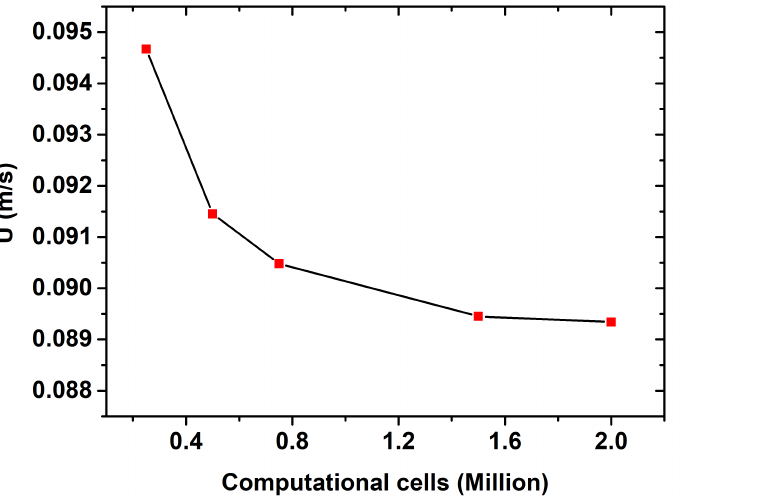
Figure 5. Velocity in the outlet 1 of the carotid model under different number of computational